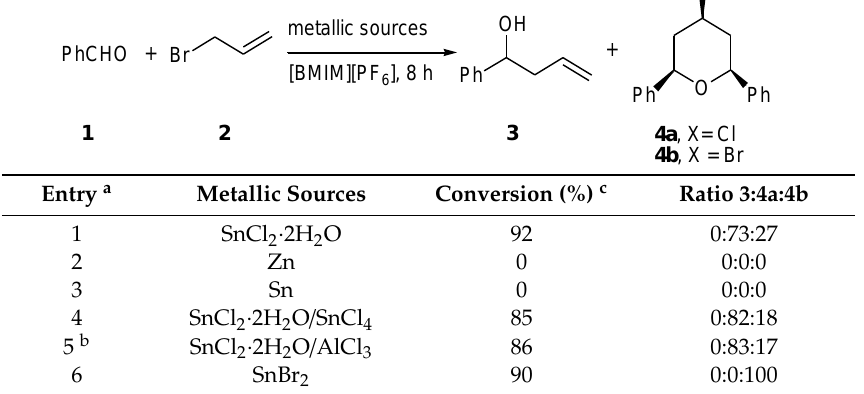
Table 3. Reaction of benzaldehyde (1) with allyl bromide (2) in [BMIM][PF 6 ], varying the metallic sources.